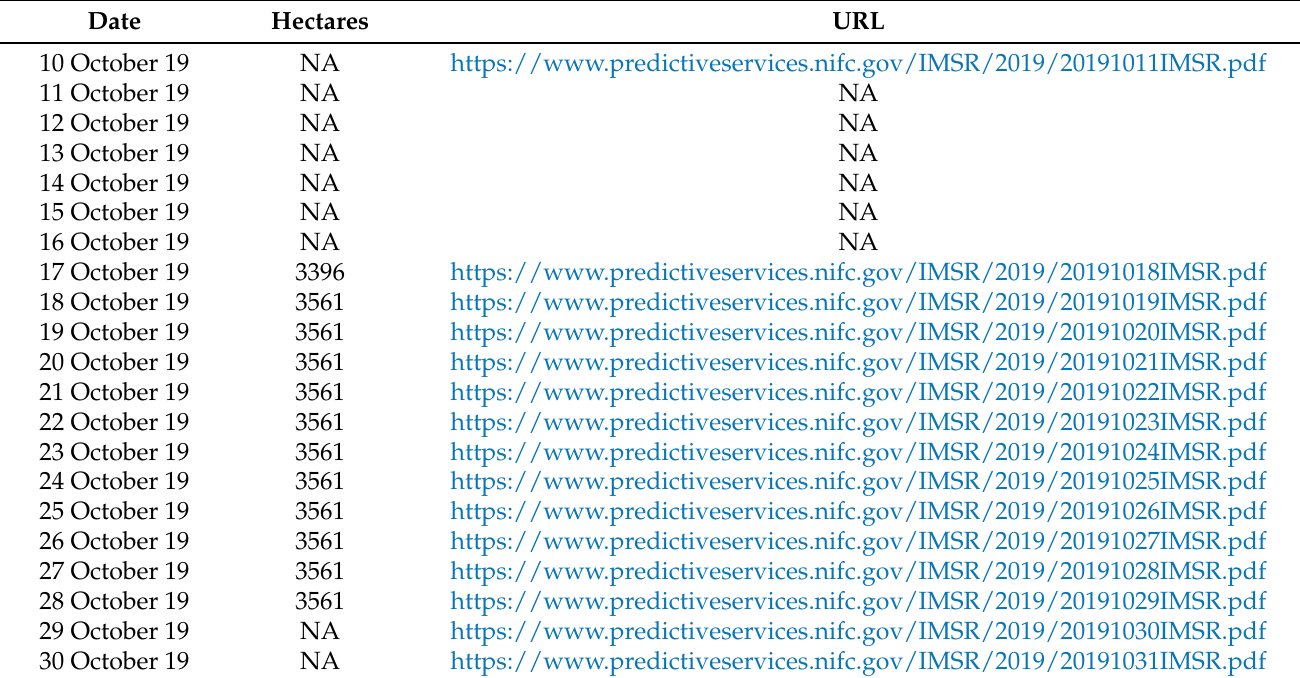
Table 2. Incident Management Situation Report cross-check data for the Saddleridge fire (2019).